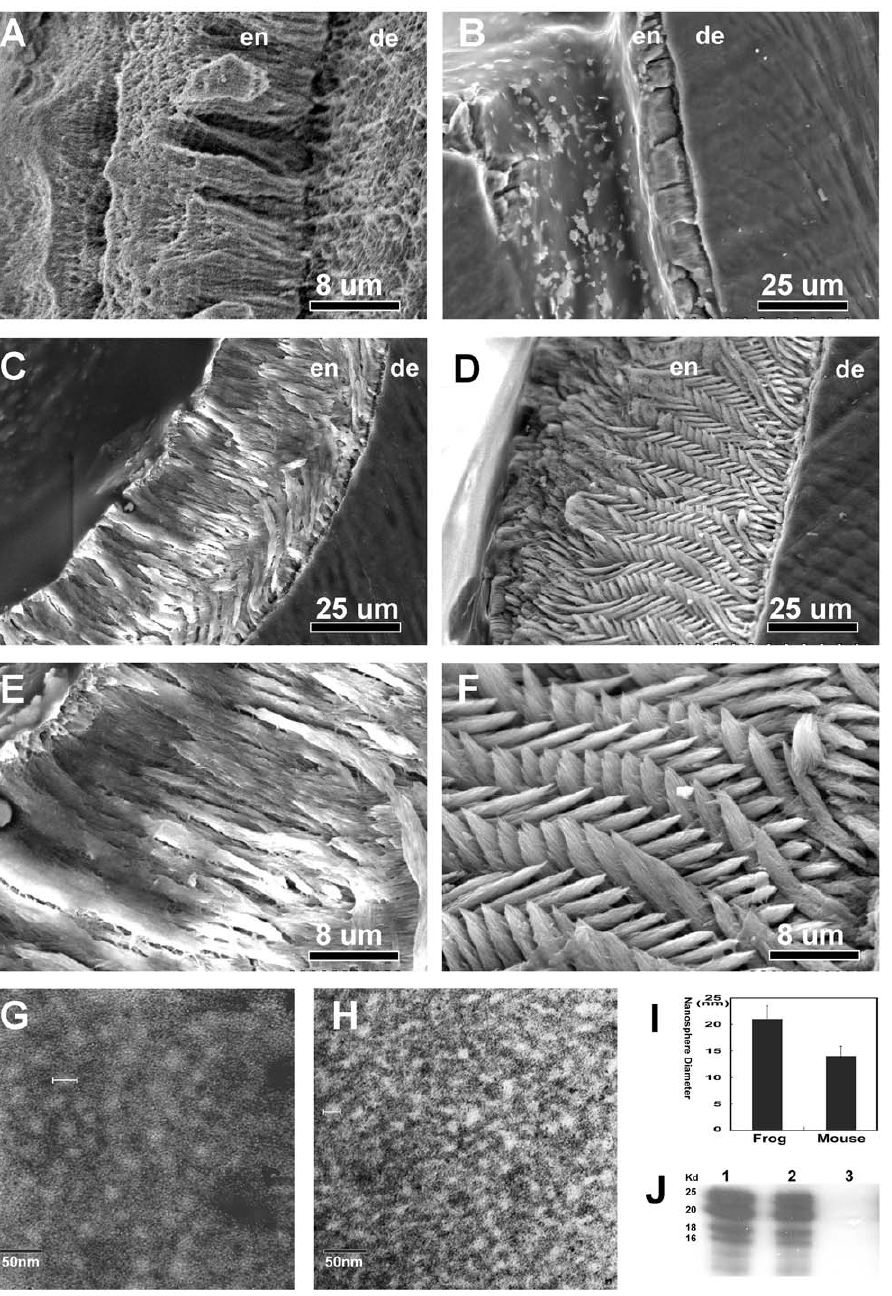
Figure 3. Differences in enamel prism formation and enamel matrix structure between molars from wild-type and frog amelogenin overexpressing mice. Note the prism-less organization of frog enamel (A) and the complete loss of structured enamel in the amelogenin null mice (B). In these scanning electron micrographs, enamel (en) and dentin (de) were labeled for orientation purposes. Frog amelogenin overexpressing offspring crossed with amelogenin null mice (fAmel-x-null) demonstrated reduced enamel thickness (C/E versus D/F) and grossly altered enamel prism structure with fused individual crystallites, especially in the coronal half of the transgenic enamel layer (C/E versus D/F). Notably, fAmel-x-null mouse enamel lacked the regularly intercrossed prism pattern found in wild-type mouse molars (C/E versus D/F). In order to compare the effect of frog amelogenins on enamel matrix structure when compared to mouse amelogenins, enamel matrix nanosphere diameters were determined on transmission electron micrographs from the enamel matrix of developing mouse first mandibular molars (G–I). Subunits measured 20.9 6 2.6 nm in frog enamel chimera and 13.9 6 1.9 nm in their wild-type controls (G–I). Enamel matrix nanosphere dimensions in fAmel-x-null enamel exceeded those of regular mouse enamel by about 50%. (G–I) Cleavage patterns of extracted mouse enamel proteins from fAmel-x-null mice (lane 1) and wild- type mice (lane 2) were almost identical (J), while there was no amelogenin detected in amelogenin null mice (lane 3). Equal protein loads were subjected to an antibody against recombinant amelogenin for Western blotting (J).